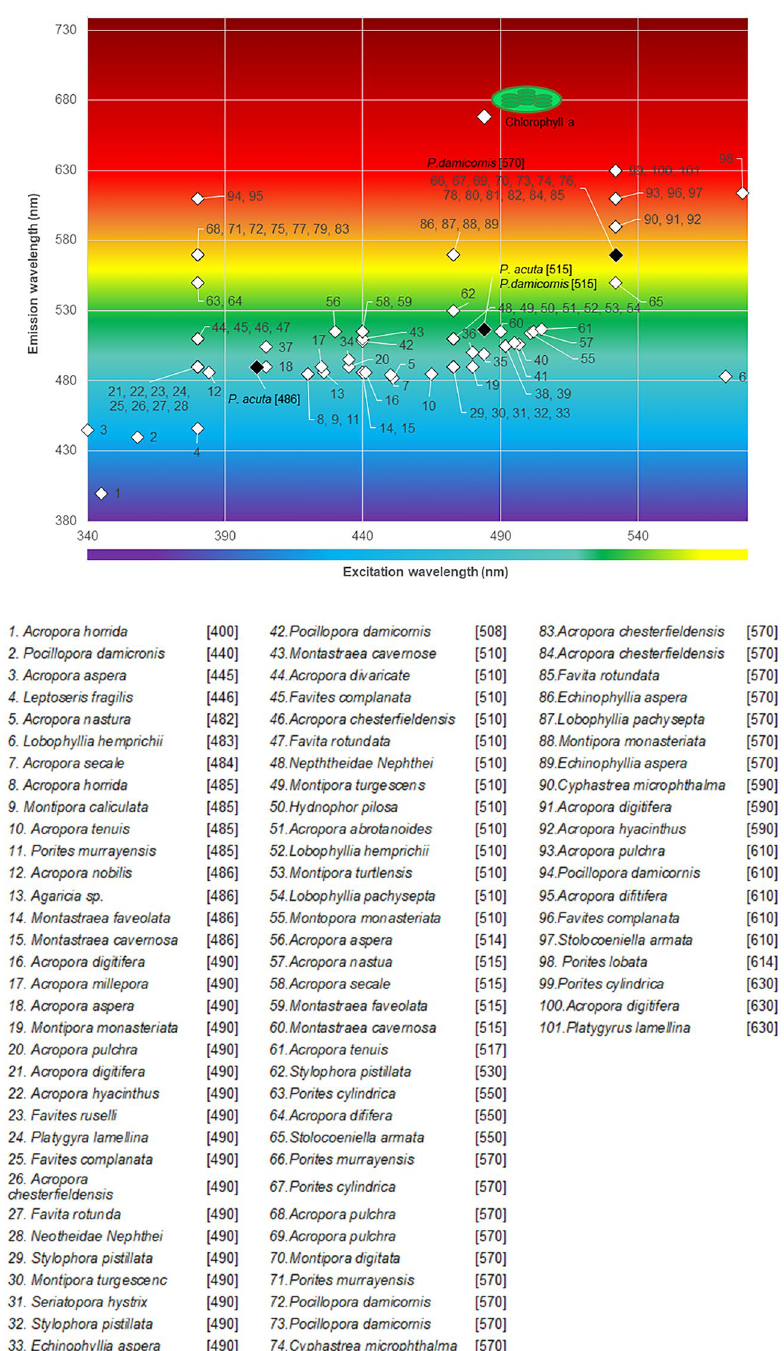
Figure 1. 101 Coral chromophores. Selection of 101 coral chromophores excitation (λ ex ) and emission (λ em ) wavelengths reported in 10 different coral families (43 scleractinian coral species) and measured in Pocillopora damicornis (this study). Coral species are listed with number key corresponding to the graph and [emission wavelength] detected (and reported in literature). References are as follow: (1–3, 8–9, 11, 17, 20, 35–36, 38) 49 ; (4) 50 ; (5, 7, 10, 19, 55–57, 61) 51 ; (6) 52 ; (12) 53 ; (13) 19 ; (14–15, 58–59) 54 ; (16, 60) 55 ; (18, 37) 56 ; (21–33, 44–54, 62–97, 99–101) 57 ; (39) 58 ; (34, 41) 17 ; (40) 18 ; (42) 59 ; (43) 60 , (98) 20